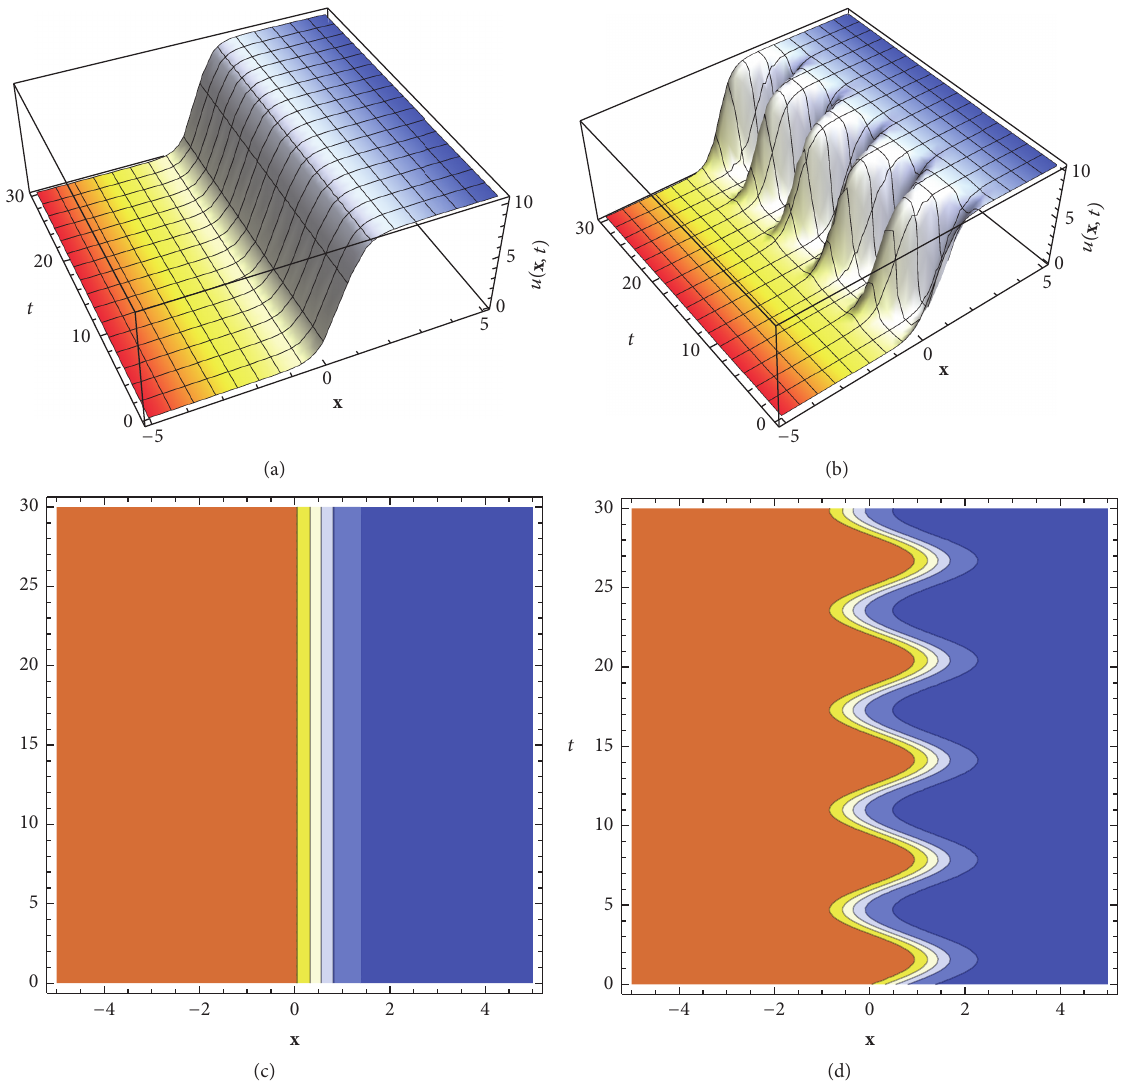
Figure 1: Profiles of the exact solution (37): (a) kink traveling wave solution without white noise term 𝐵(𝑡) = 0 , (b) kinks traveling wave solution with 𝐵(𝑡) = sin (𝑡) , (c) 2D contour of (a), and (d) 2D contour of (b).